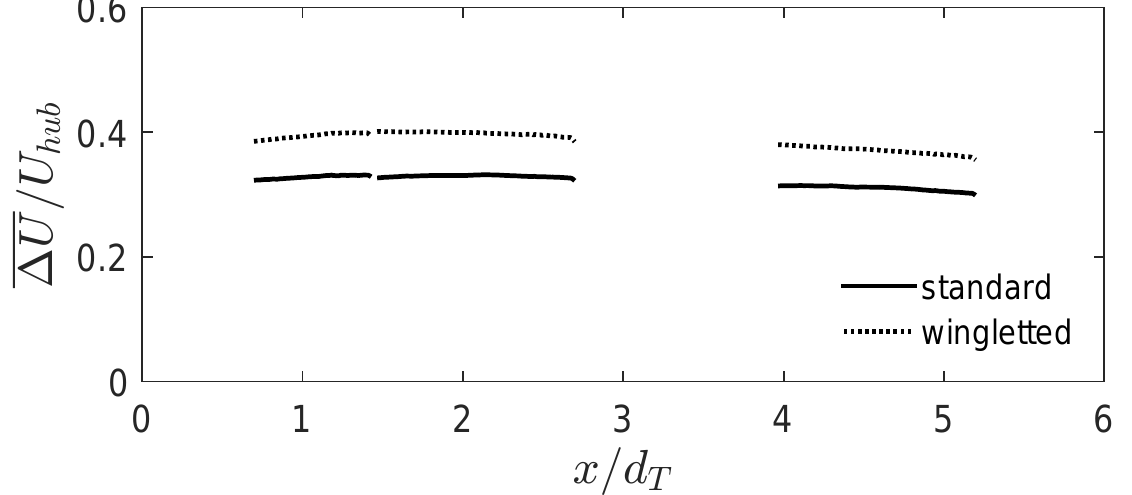
Figure 7. Non-dimensional average wake deficit ∆ U/U function of downstream